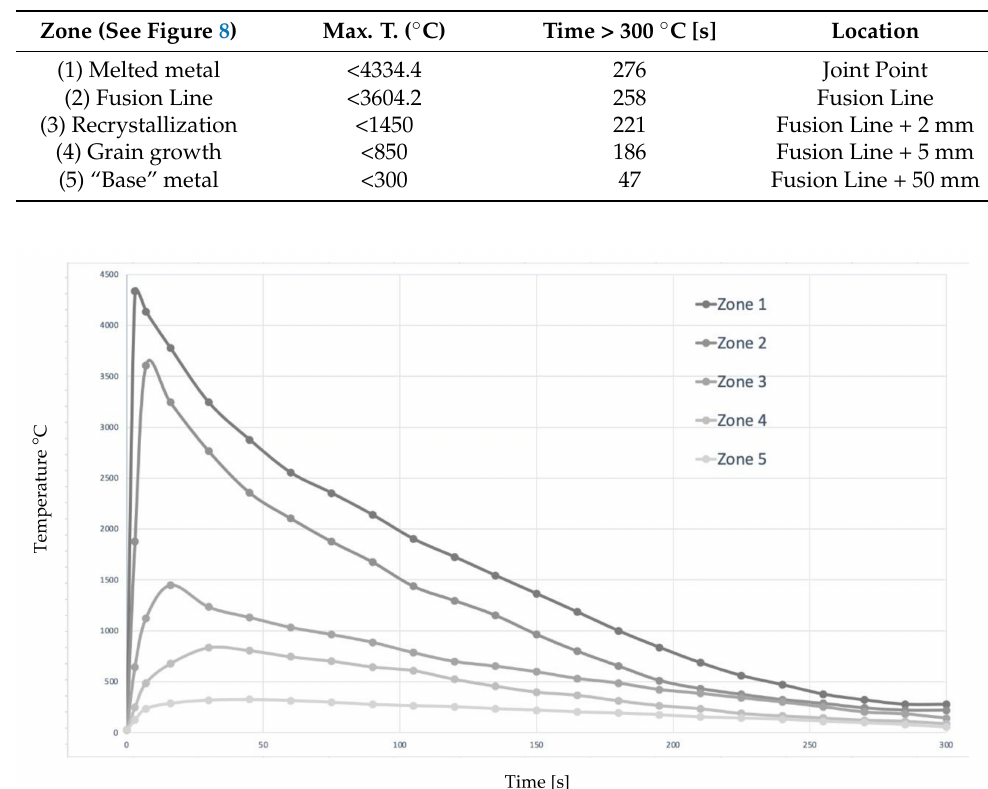
Table 5. Correlation thermal cycle microstructure.